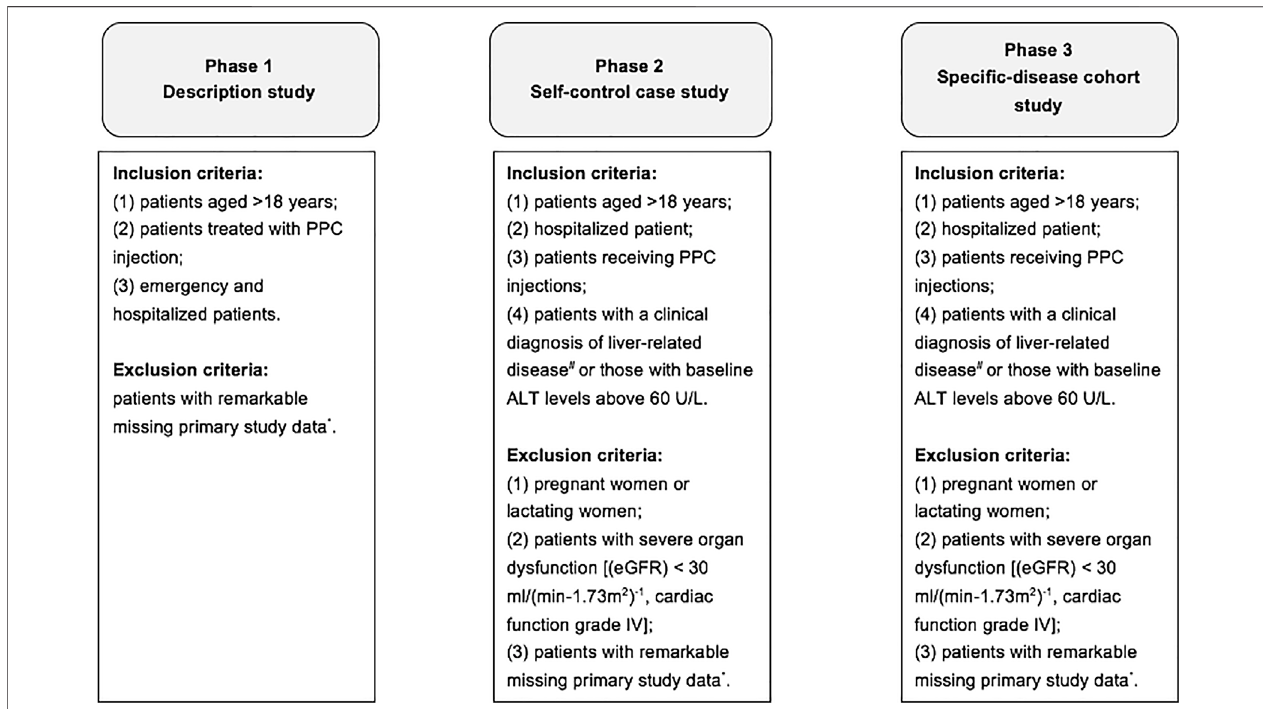
FIGURE 1 | The work fl ow of the whole study. Notes: * indicates patient ID, age, gender, and information related to disease diagnosis. # indicates various types of hepatitis, cirrhosis, alcoholic liver disease, nonalcoholic fatty liver disease, drug-induced liver disease, autoimmune liver disease, liver fi brosis, hepatic encephalopathy, hepatolenticular degeneration, liver cancer, liver transplantation, hepatobiliary surgery, common liver- occupying lesions, and other causes of abnormal liver function. Abbreviations: eGFR, estimated glomerular fi ltration rate.